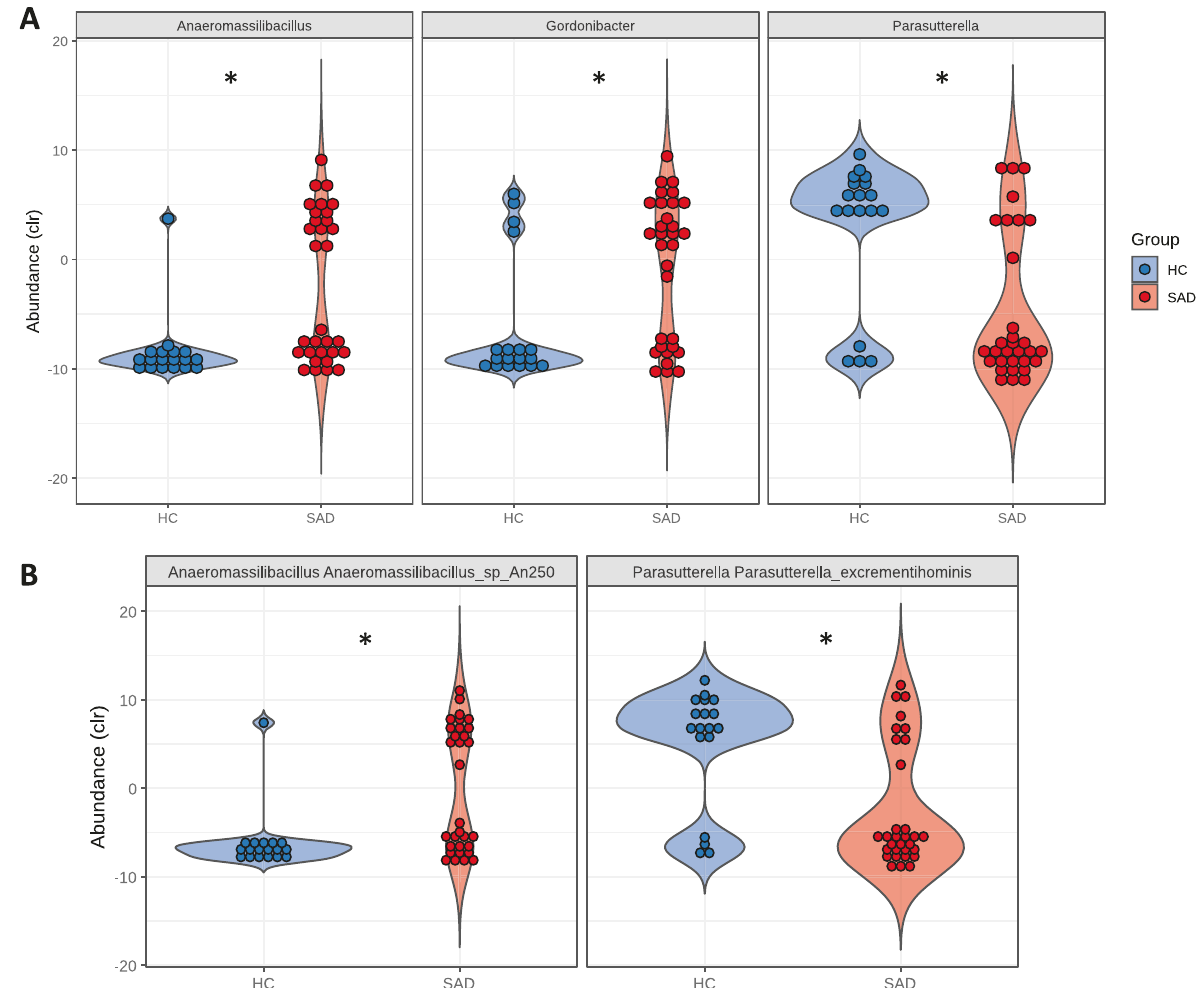
Fig. 2 Genus and species level differences between SAD and healthy controls. A Genus-level differences in relative abundance between SAD and controls seen in three genera; Anaeromassillibacillus and Gordonibacter are enriched in SAD while Parasutterella is enriched in healthy controls. B Species-level differences in relative abundance between SAD and controls; Anaeromassilibacillus sp An250 is increased in SAD while Parasuterella excrementihominis is enriched in healthy controls. (* p = <0.05) (Clr centred log-ratio transformed, HC Healthy Control, SAD Social Anxiety